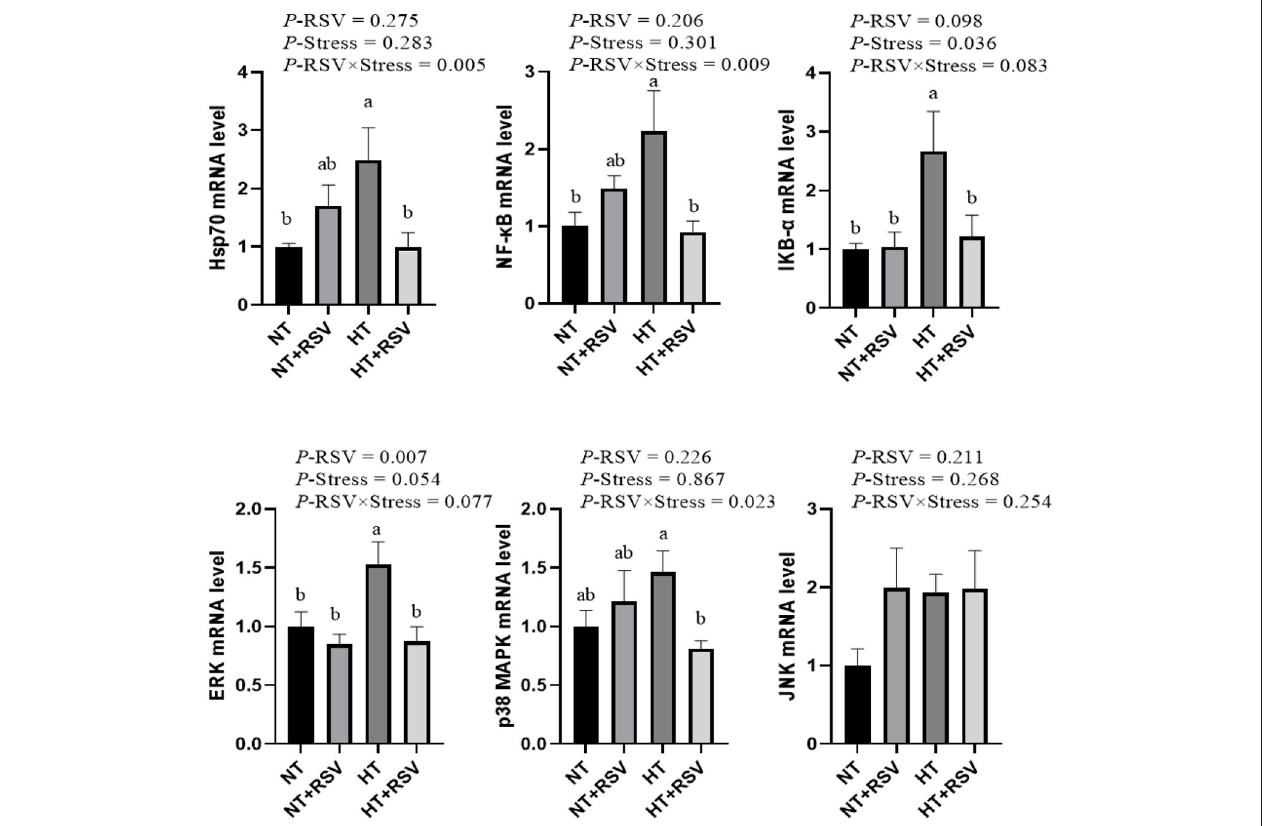
FIGURE 6 | Effect of heat stress and RSV on immune signal pathway genes expression levels in spleen of 42-day-old broilers (d 14 of heat treatment). Bars represent the means ± SEM ( n = 6), bars with different letters are statistically significant in different treatments. P -values ( P -RSV, P -Stress, or P -RSV × Stress) ≤ 0.05 indicates RSV, heat stress, or the interaction between heat stress and RSV. RSV, resveratrol; NT, normal temperature; HT, heat